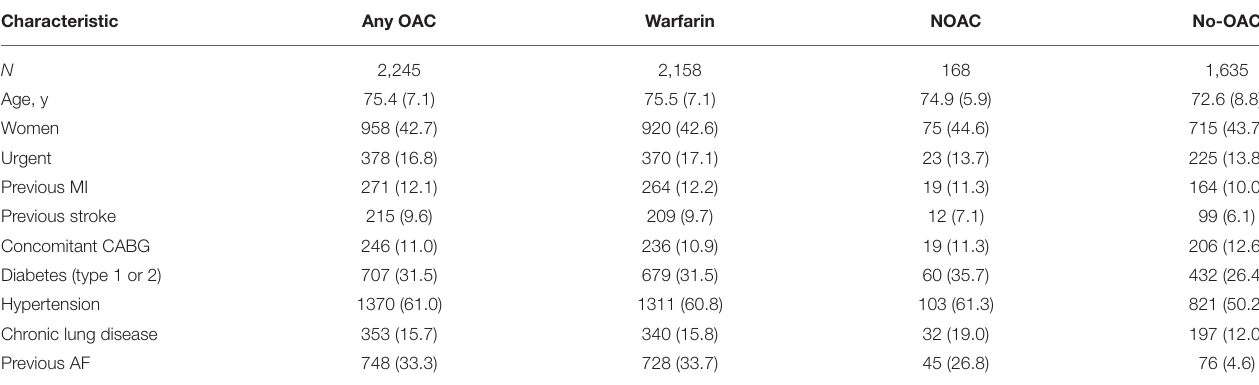
TABLE 1 | Characteristics of BAVR patients 3 months after the operation between 2010 and 2016 ( n = 3,880). Characteristic